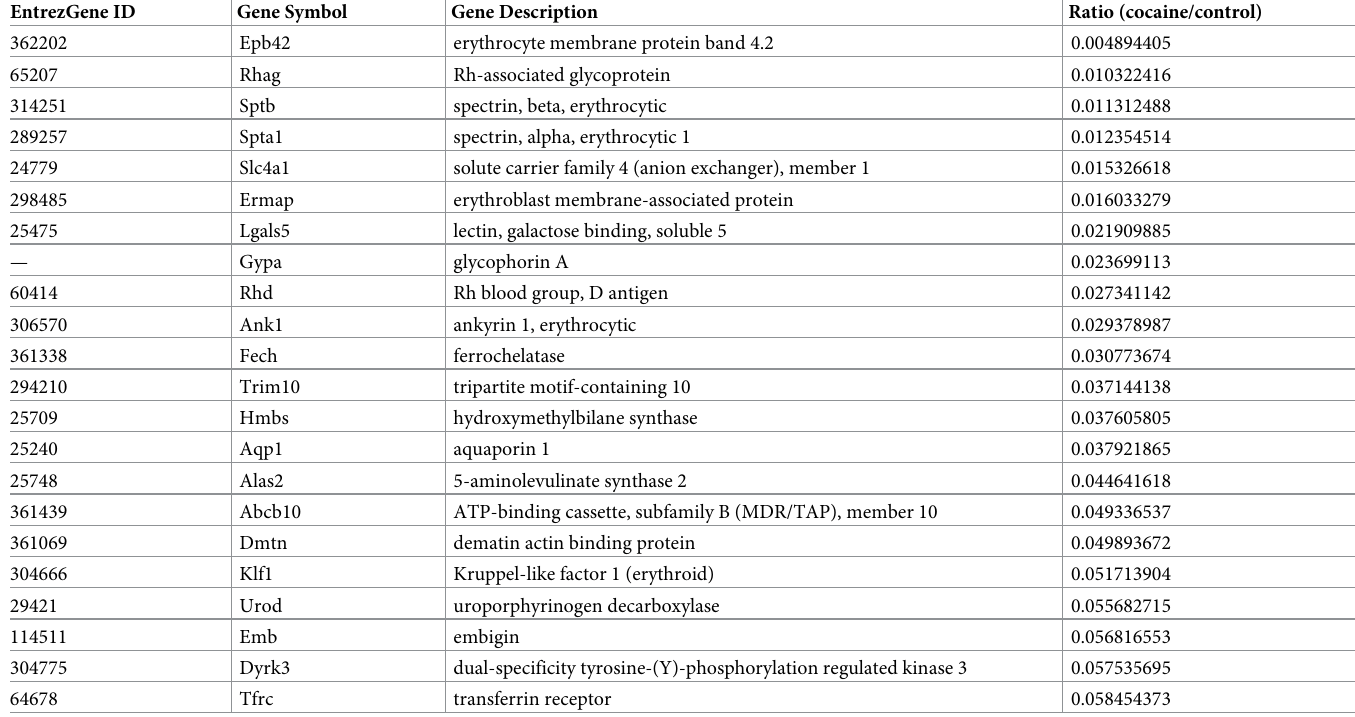
Table 2. List of 22 genes related to RBC that are included among the top 50 genes downregulated by cocaine. EntrezGene